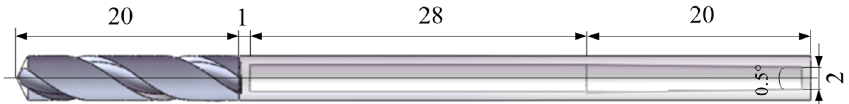
Figure 3. Structure of the RHPD.